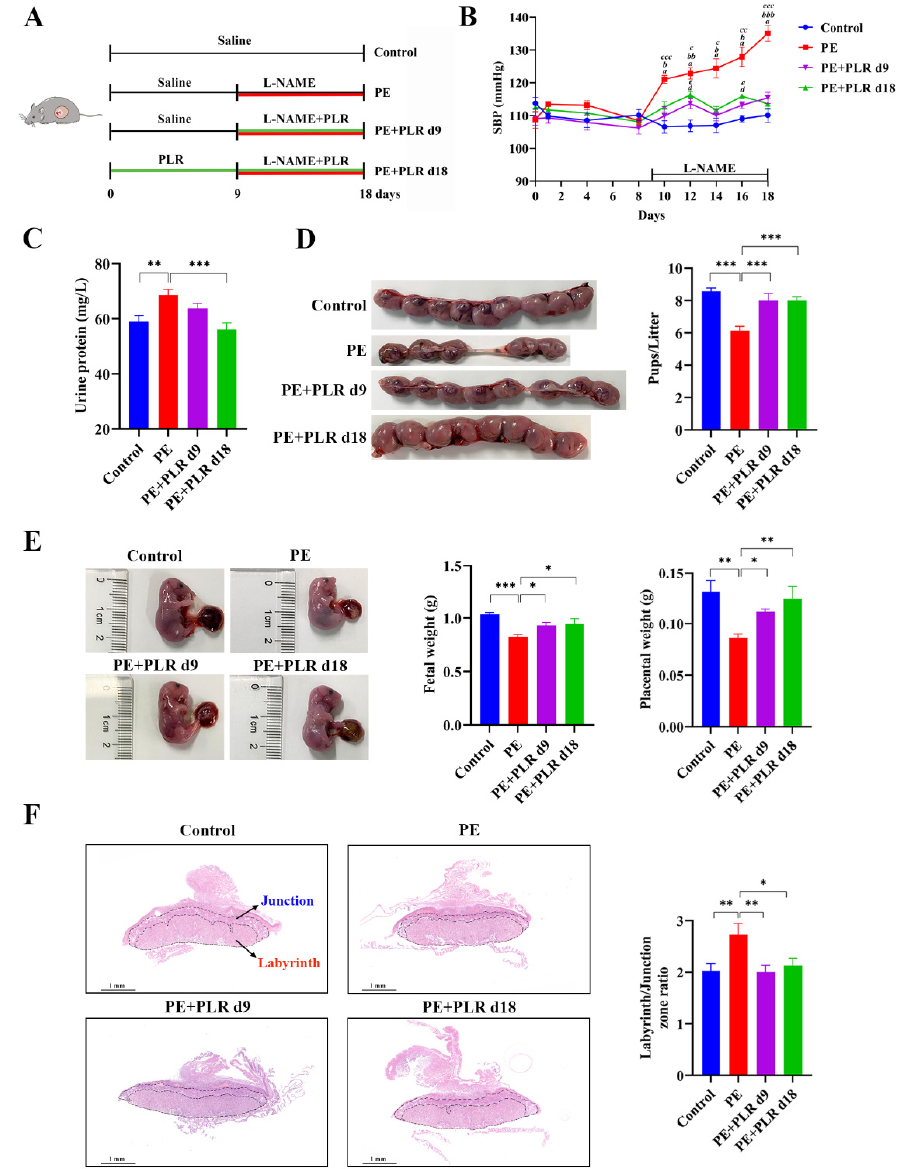
Figure 1. Puerariae lobatae Radix (PLR) alleviated pre-eclampsia (PE)-like symptoms in NG-nitro- L-arginine methyl ester (L-NAME)-induced mice. ( A ) The schematic diagram of the experimental design and procedure. ( B ) Systolic blood pressure (SBP) of the four groups was measured non- invasively. a indicates p < 0.001 for the Control group versus the PE group on the corresponding day. b indicates p < 0.05, bb indicates p < 0.01, and bbb indicates p < 0.001 for the PE+PLR d9 group versus the PE group on the corresponding day. c indicates p < 0.05, cc indicates p < 0.01, and ccc indicates p < 0.001 for the PE+PLR d18 group versus the PE group on the corresponding day. d indicates p < 0.05 for the Control group versus the PE+PLR d9 group on the corresponding day. e indicates p < 0.05 for the Control group versus the PE+PLR d18 group on the corresponding day. ( C ) The 24 h proteinuria on GD18. ( D ) Number of pups per litter. ( E ) Fetal weight and placental weight. ( F ) Representative images of H&E-stained midsagittal placental tissue sections used in histomorphological analysis (original magnification, × 25; scale bar, 1 mm). Zones are marked and indicated by labyrinth zone and junctional zone. For ( B , D , E ), n = 8 for each group. For ( C ), n = 7 for each group. For ( F ), n = 6 for each group. Data are expressed as the mean ± SEM. * p < 0.05, ** p < 0.01, *** p < 0.001 (ANOVA